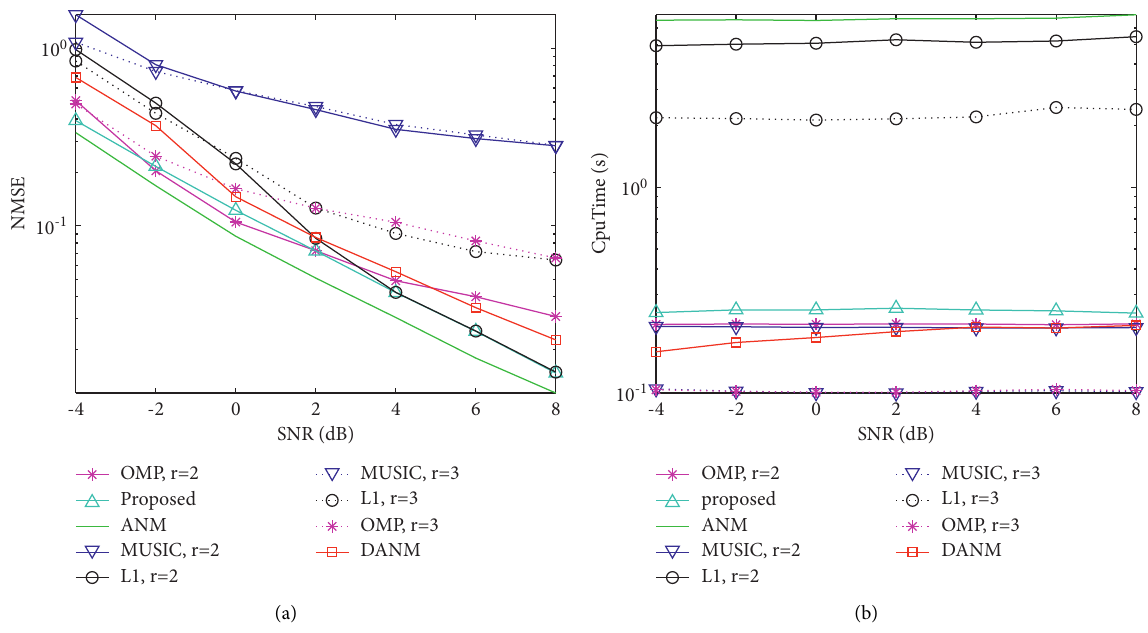
Figure 4: Channel estimation performance comparison with respect to the SNR. Two grid resolutions 2 ∘ and 3 ∘ are considered. (a) NMSE comparison. (b) CPU time comparison.